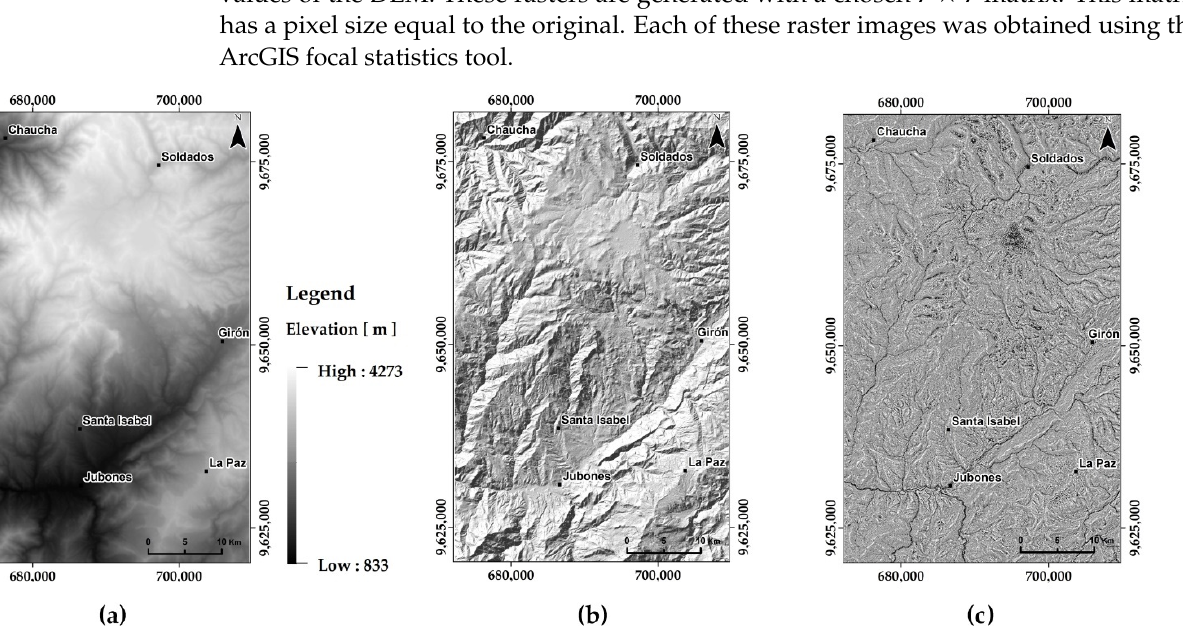
Figure 6. DEM and its derived models. ( a ) DEM ALOS PALSAR with a spatial resolution of 12.5 m; ( b ) hillshade model with an azimuth of 135°; and ( c ) TPI model.